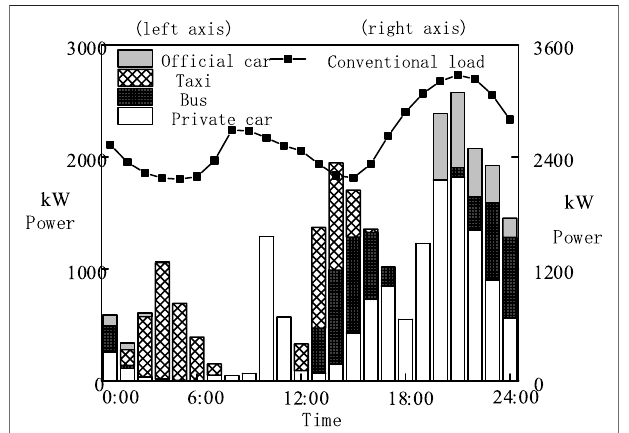
FIGURE 6 | Expected charging power for four EV types.